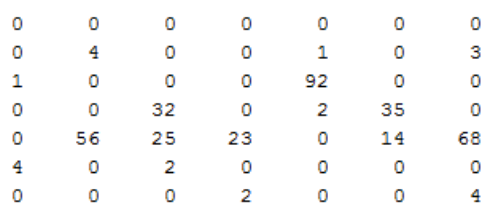
Figure 8. Left width of the fuzzy matrix.